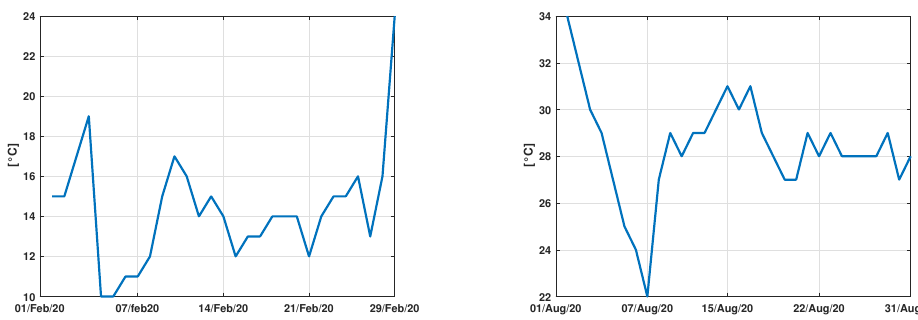
Figure 16. Site 1—Atmospheric temperature averaged values: February 2020 ( left ) and August 2020 ( right ).